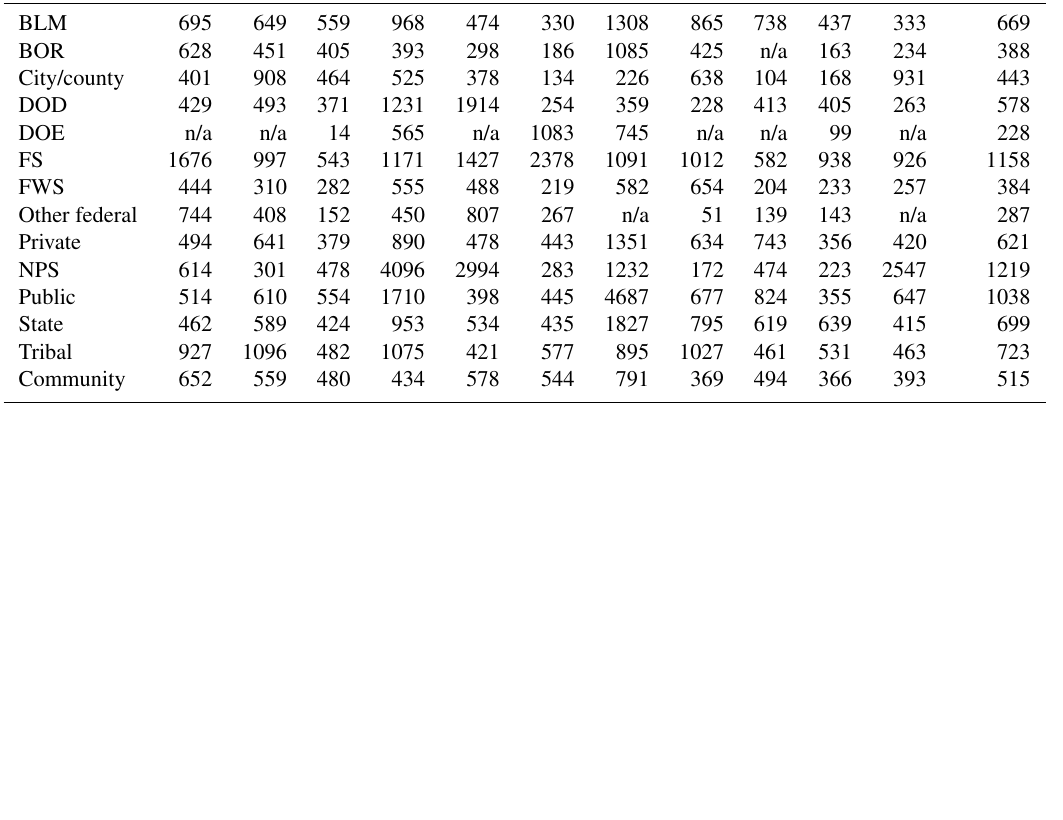
Table B3. Predicted average fire size from all the ignitions of each land tenure and state, expressed as hectares burned per year. Land tenure